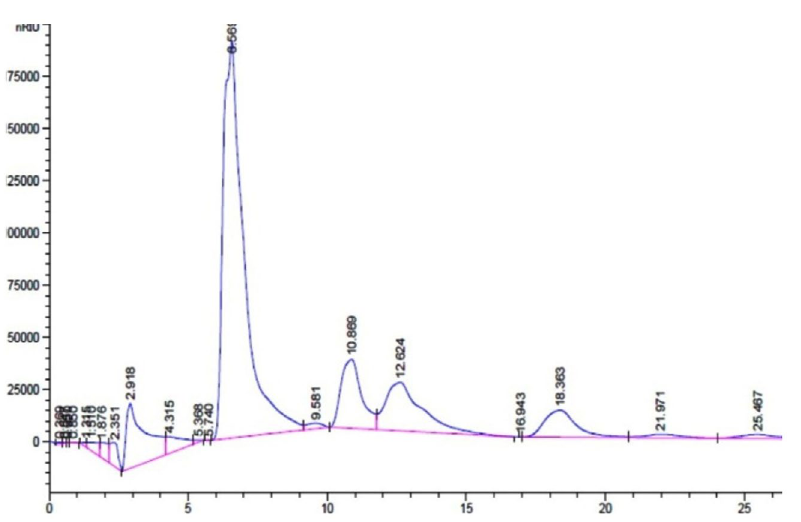
Fig. 6. L. fermentum with retention factor- Galactose and Glucose 2.931, Lactose 6.56, disaccharides 10.83 and 12.68, trisaccharides 16.95 and 18.36 and tetrasaccharides 21.9 and